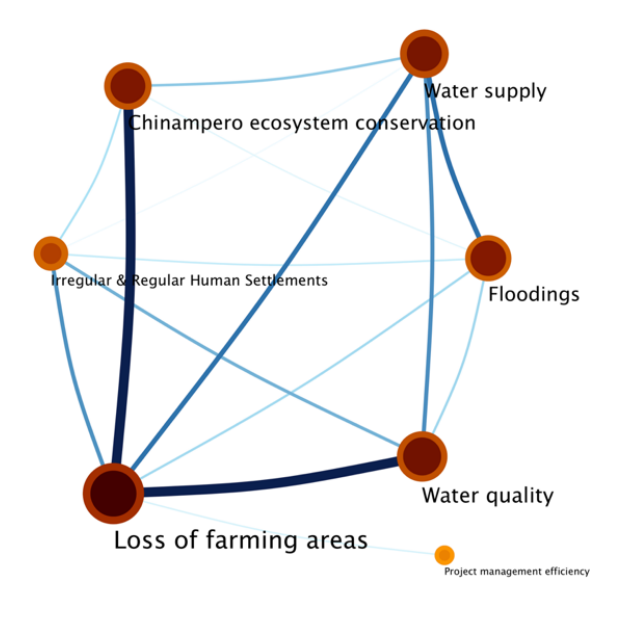
Fig. 3 . Communities of terms from the mental models of the 13 interviewees in Xochimilco. Each node represents a suite of terms that are strongly associated with each other, thus conforming a broader narrative. The different narratives share some terms, represented by the thickness of the lines connecting each community of